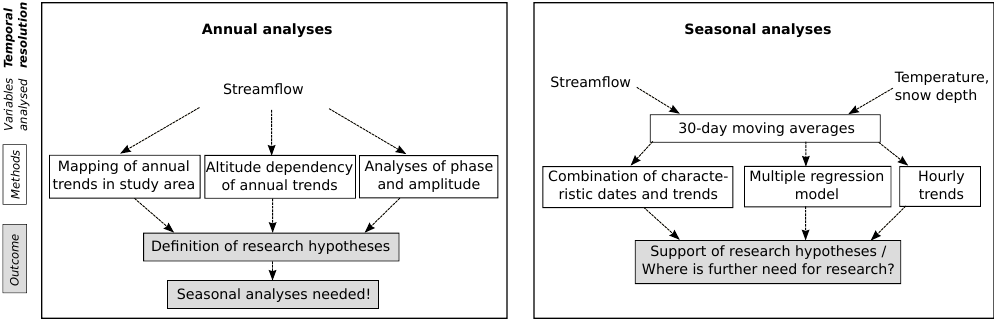
Figure A1. Schematic illustration of the structure of the analyses.